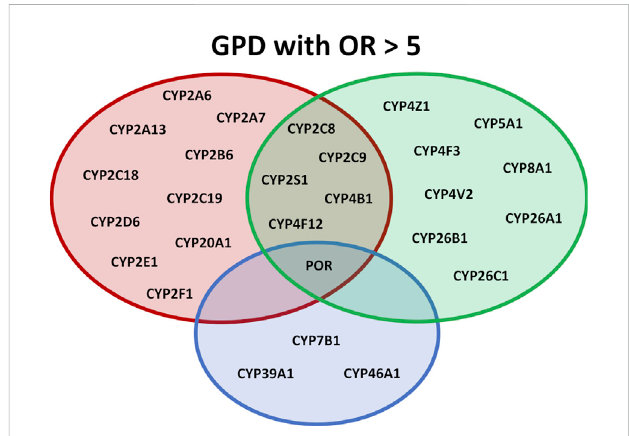
FIGURE 1 Overview of the effect of different SNPs in cytochromes P450 on various physiological pathways. P450s are shown which display OR values > 5.0 in GPD patients. In the red circle P450s are listed participating in the biotransformation of xenobiotica, in the green circle P450s are listed participating in immune response and in fl ammation and in the blue circle P450s are shown involved in sterol metabolism or the degradation of